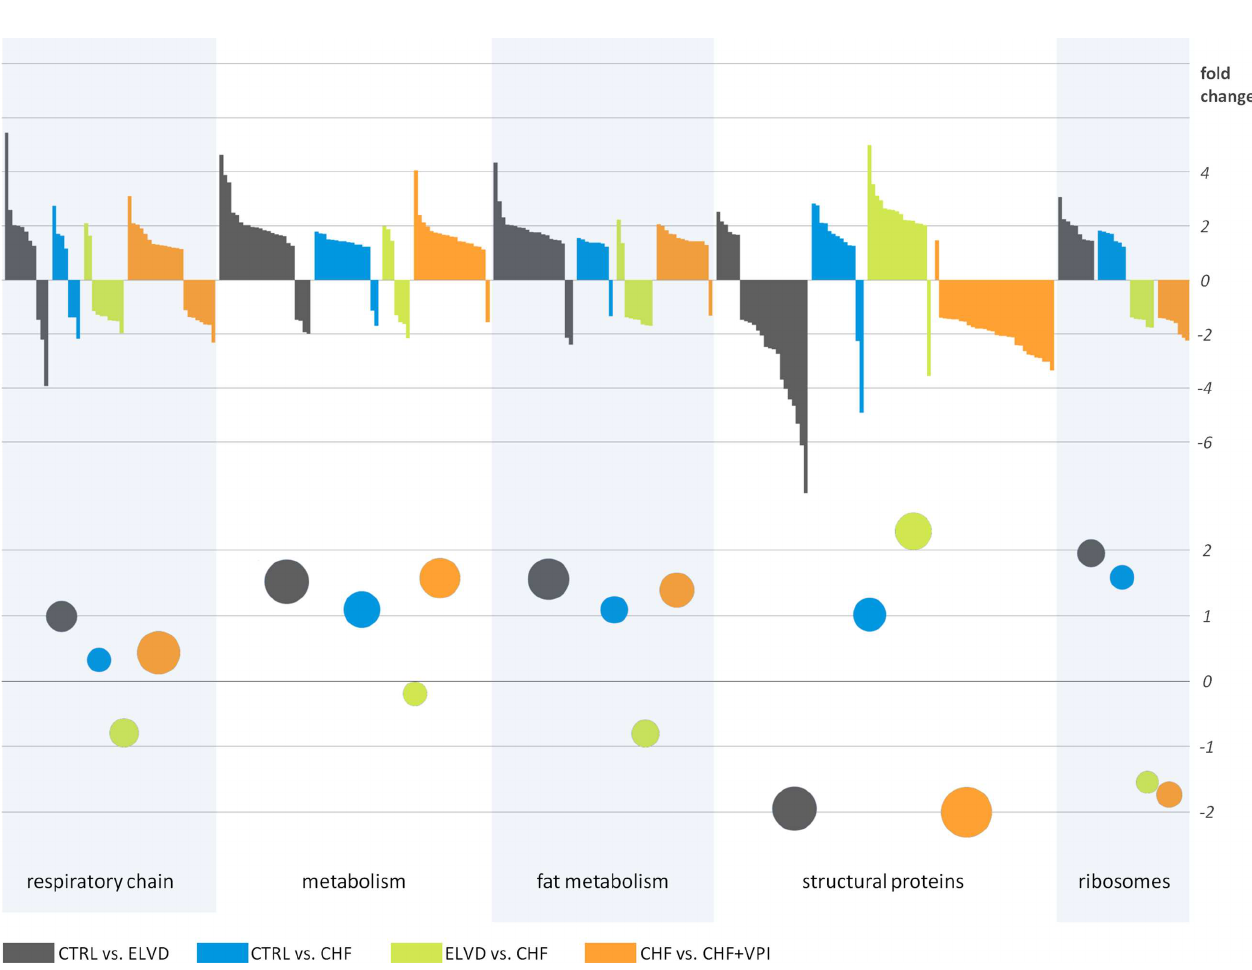
Fig 2. Synopsis of qualitative and quantitative proteomic results. Each color represents comparisons betweentwo groups: gray, CTRL vs. ELVD; blue, CTRL vs. CHF; green, ELVD vs. CHF; orange, CHF vs. CHF+VPI. Data are categorized by functionalassignmentof the proteins to 5 classes: proteins belongingto the respiratory chain, metabolism, fat metabolism, cellularstructure, and ribosomes. Each bar in the upper part of the figure representsone differently expressed protein with its fold change, respectively. Coloredcircles in the lower part of the figure each indicate the mean value of fold changeswith the size of circles representingthe numberof differentiallyexpressedproteins. The coloursof the circles again reflect the comparisongroups as detailedabove. “Metabolism” comprises proteins with metabolicpropertiesexcept for the ones belongingto “fat